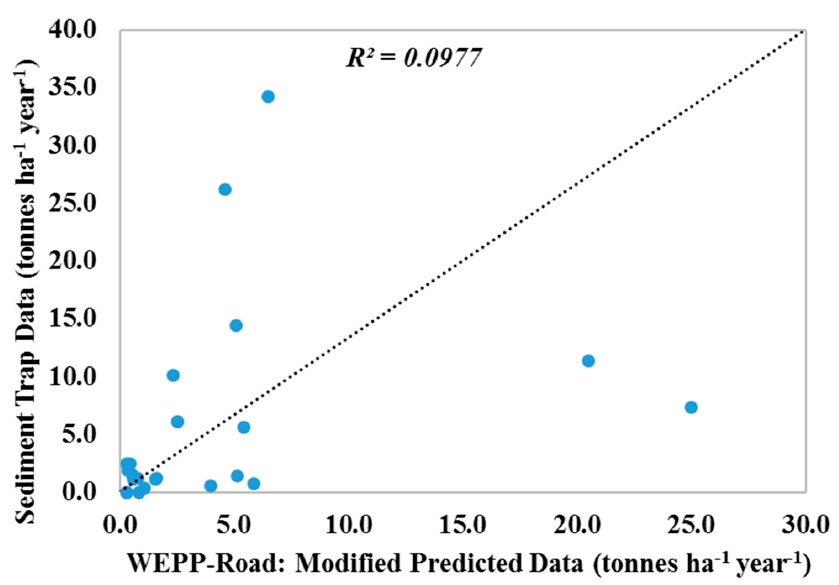
Figure 9. Linear relationship of WEPP-Road: Modified modeled data and actual erosion data. Line on graph represents a 1:1 relationship.